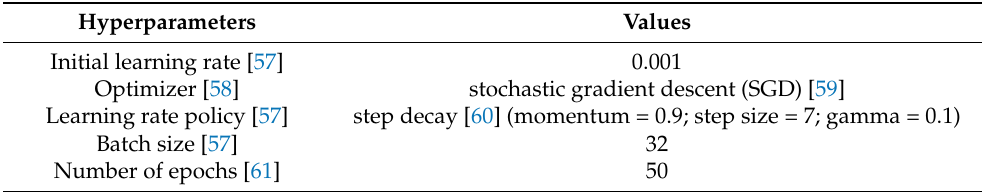
Table 2. Hyperparameters used in our